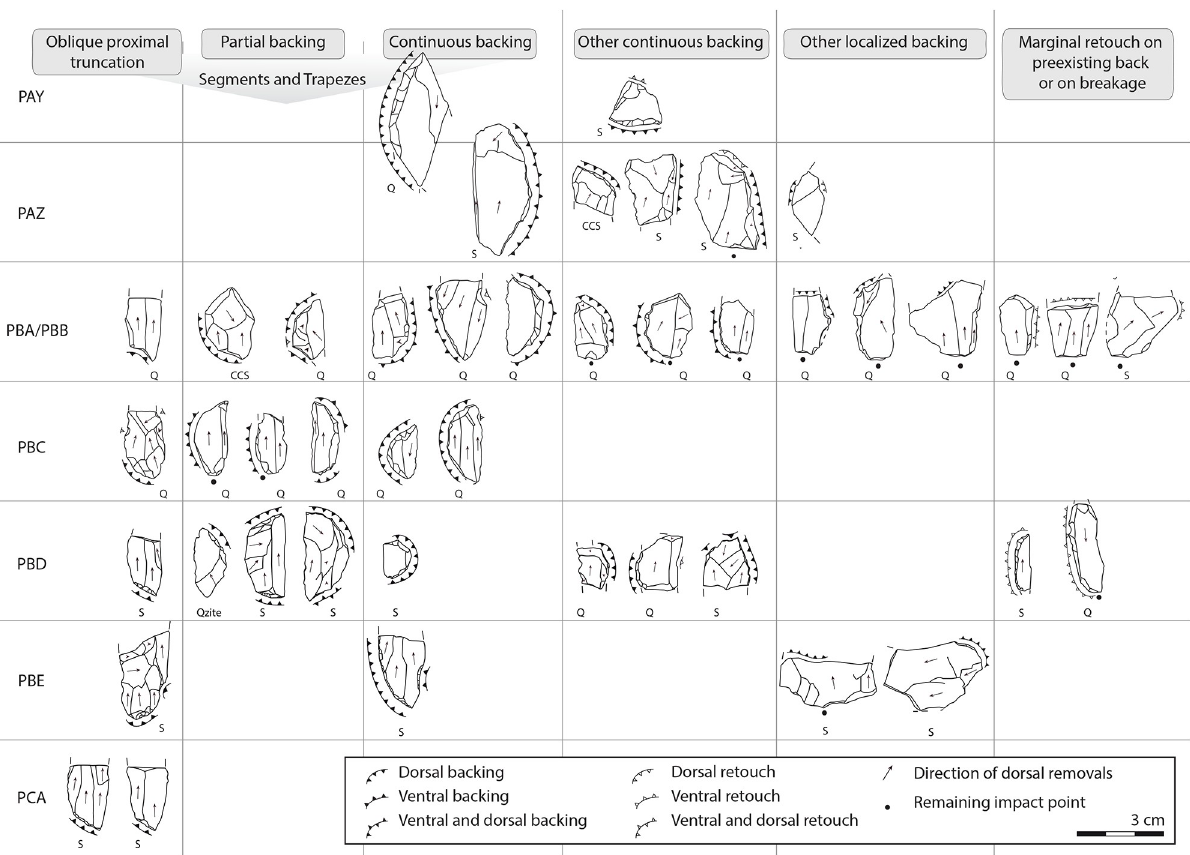
Fig 7. Examples of backed tools identified within the HP sequence of KDS. Raw material is indicated below each tool: S: Silcrete, CCS: Cryptocrystalline silica, Q: Quartz, Qzite: Quartzite. For proportions of each backed tool type per layer, refer to Table 6. Piece with continuous backing illustrated here for layer PAY comes from another ¼ square meter than those studied in this paper. Technical drawings distinguish dorsal from ventral removals as well as backing removals (= abrupt to vertical) from retouch removals that do not create a back and that may occur side by side on a single